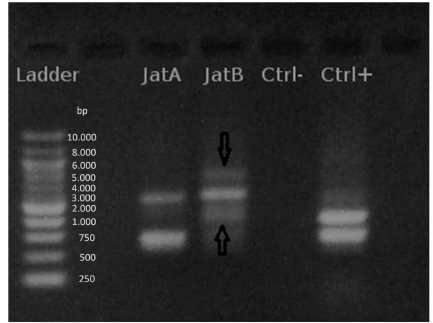
Figure 4. Amplification of cDNA of genotype A (JatA) and B (JatB) obtained from J. curcas applying MG82 primer. Ladder = DNA molecular size marker; CTRL − = negative control (no cDNA); CTRL + = positive control (cDNA that has been successfully used in previous